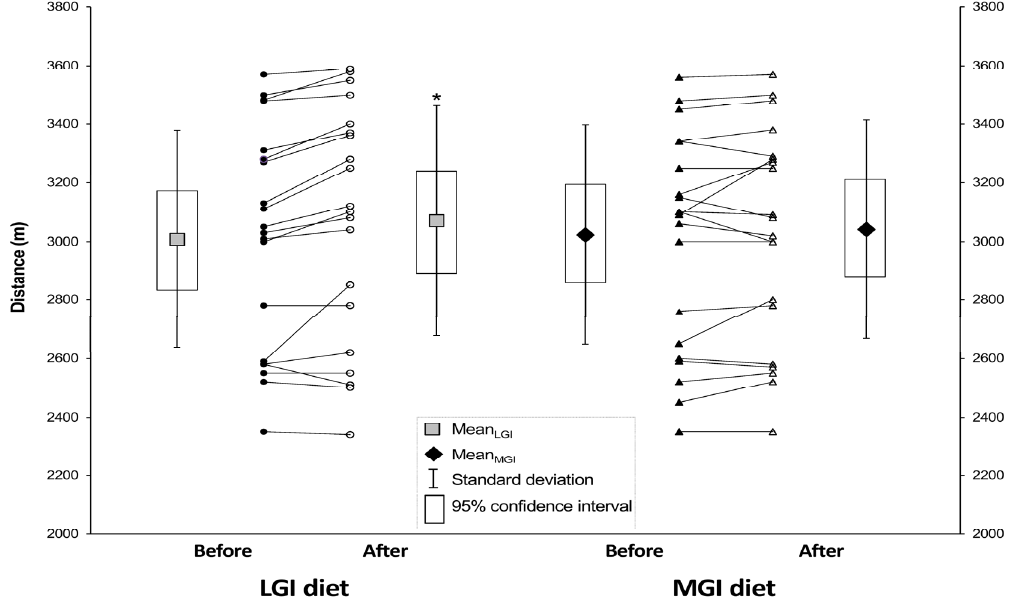
Figure 2. Mean distance covered in the running test before and after the three-week LGI and MGI diets. Values are means ± SD (and 95% confidence intervals). Abbreviations: MGI—moderate glycemic index, LGI—low glycemic index. * Significantly different from baseline ( p = 0.0015).